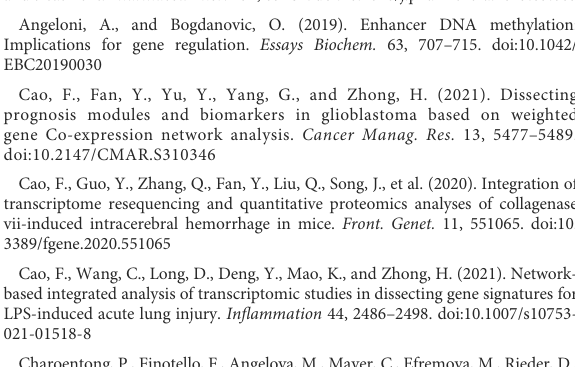
SUPPLEMENTARY TABLE S1 TCGA-GBM clinical information statistics in the present study. SUPPLEMENTARY TABLE S2 The overall in fi ltration results by CIBOERSORT algorithm. SUPPLEMENTARY TABLE S3 Details of 612 DEGs among DNA5mC